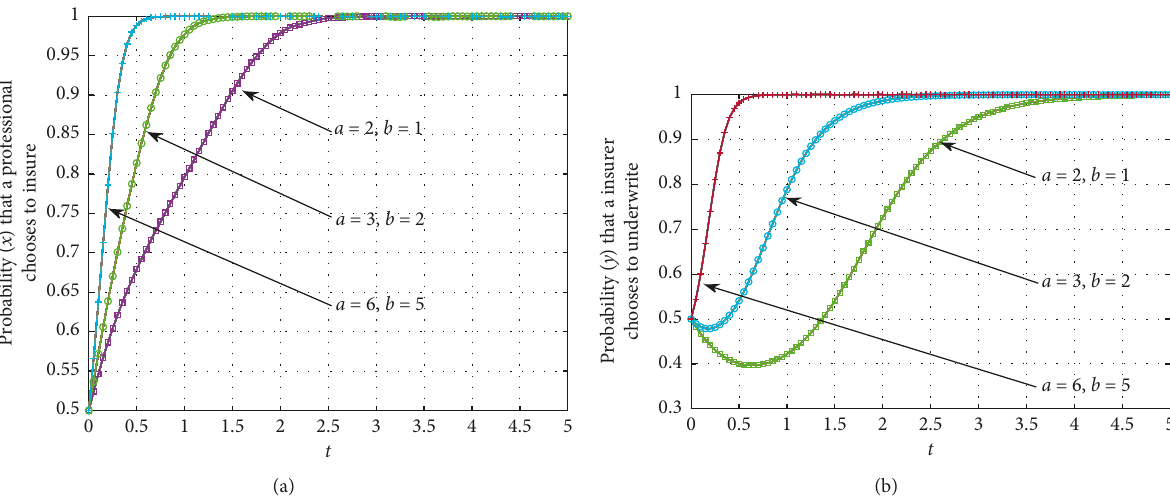
Figure 3: The impact of credit income ( a ) and opportunity cost ( b ) on the evolution of (a) professional’s strategy and (b) insurer’s